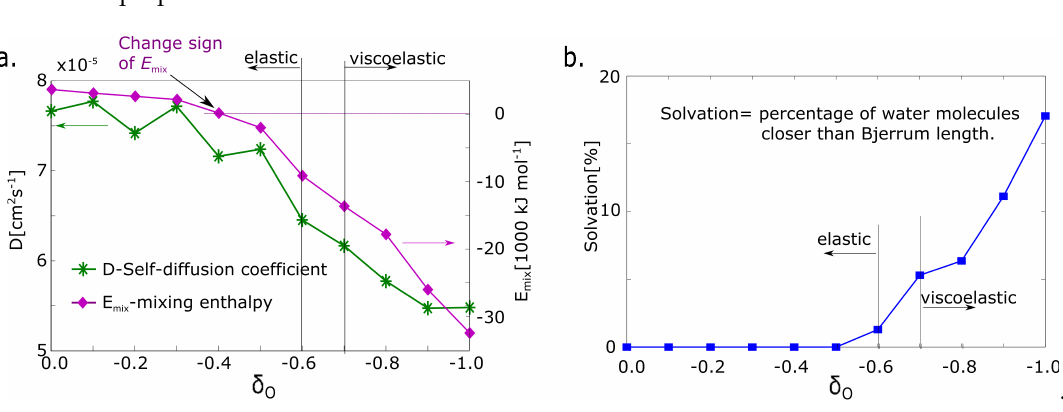
Figure 5. Structural parameters of hydrogel models. ( a ) E mix : mixing energy calculated from simulation; D: self-diffusion coefficient of water; ( b ) degree of solvation—fraction of molecules, which are in the solvation zone (distance from macromolecular chains less than the Bjerrum